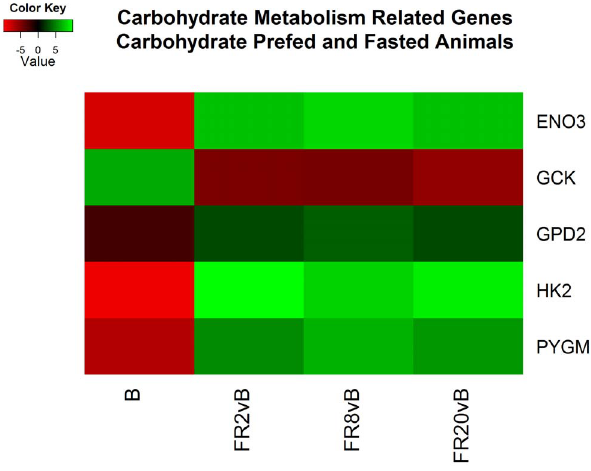
Figure 2. Heatmap of log2 fold changes of genes associated with carbohydrate metabolism between carbohydrate prefed (CPF) and fasted (FS) animals. Rows are differentially expressed genes (DEGs) following RNA sequencing. Columns denote the respective timepoints Baseline (B), 2 hours full resuscitation change from Baseline (FR2vB), 8 hours full resuscitation change from Baseline (FR8vB), and 20 hours full resuscitation change from Baseline (FR20vB). Green denotes higher concentration or larger changes in mRNA concentration in CPF whereas red denotes the opposite.